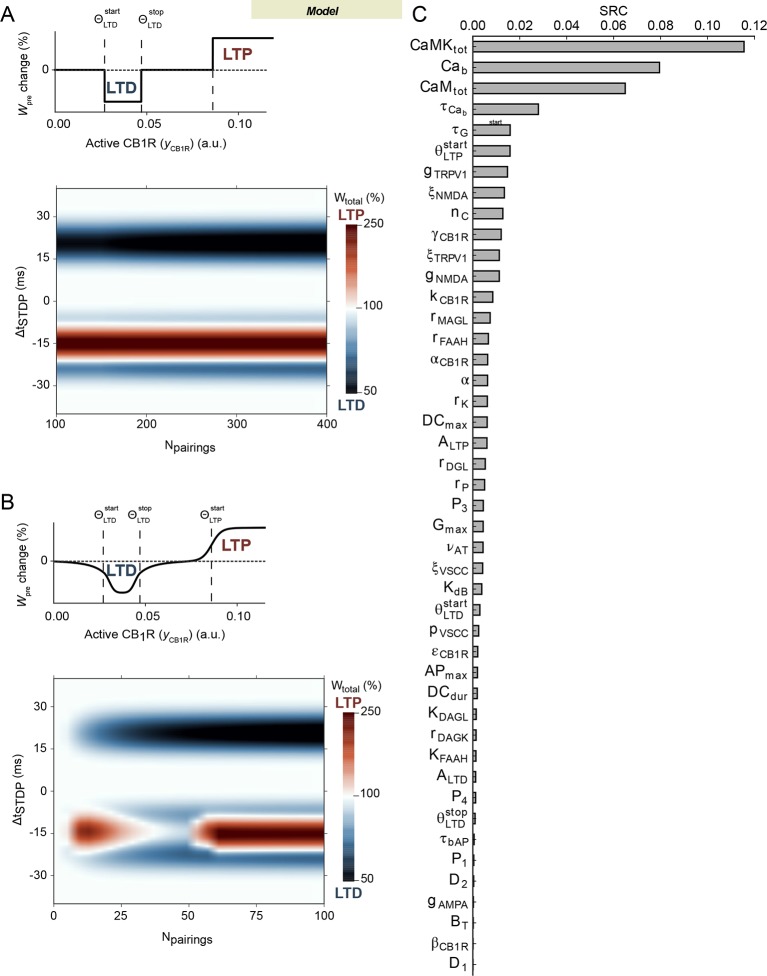
Robustness of the model.(A) Output of the model for more than 100 pairings and
(upper panel) the sharp threshold mechanism for eCB-plasticity given by
Equation 1 The
behavior observed with 100 pairings is conserved. (B) Output
of the model when the sharp eCB plasticity (Equation 1) is replaced by a smooth function (upper
panel, given by eq.S1-S2 of Supplementary file 2, here used with
kS= 2). Even without changing any of the model parameters outside
the threshold function, the model output with such smooth thresholds is
very similar to the one obtained with the sharp threshold of Equation 1 (compare with
Figure 4A1). Other values of
kS essentially lead to the same
conclusion. (C) Sensitivity analysis of the model
parameters. On the y-axis, the parameters are ranked according to their
standardized linear-regression coefficient (SRC, see
Materilas and methods) that measures the sensitivity of the model output
to variations of the parameter.